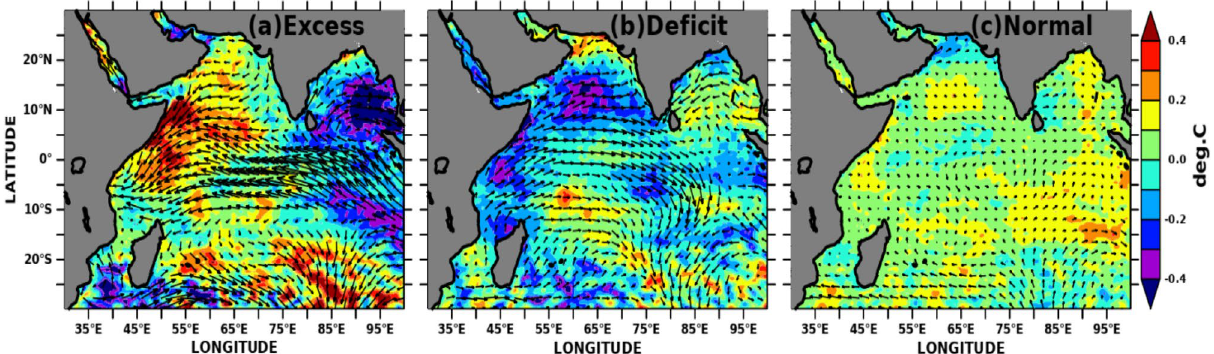
Figure 14. Composite of May month’s detrended SSTA variability (shaded) overlayed with detrended ERA5 wind anomalies (vectors) over the Indian Ocean during ( a ) excess, ( b ) deficit, and ( c ) normal monsoon years. The figure is generated using PyFerret v7.63.